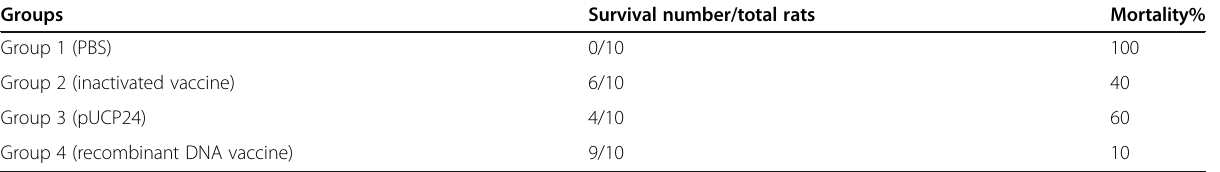
Table 1 Vaccine protective efficacy over 14 days in rats challenged with Pasteurella multocida Type A